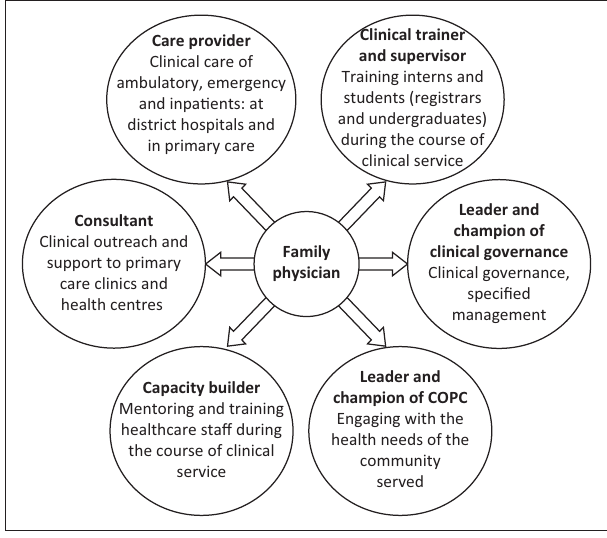
FIGURE 1: Roles and competencies expected of a family physician in South